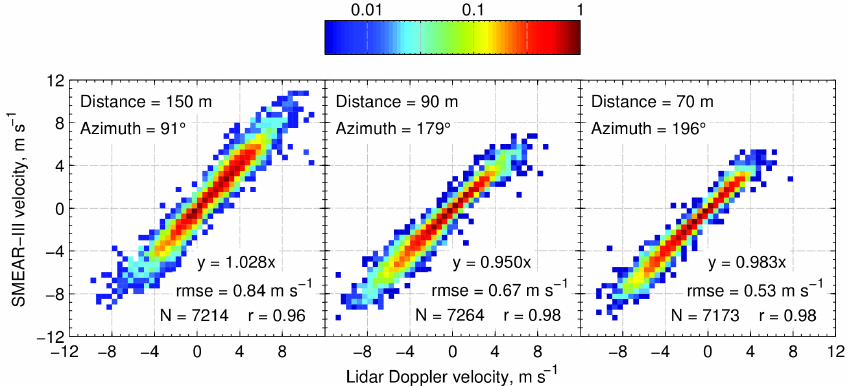
Fig. 9. Comparison of single-beam and range gate Doppler velocity with co-located sonic anemometer velocity: measurements with different horizontal separation from sonic anemometer are shown, and subsequent statistical parameters are also presented: number of half-an-hour mean velocity samples ( N ), root mean square error (RMSE), Pearson correlation ( r ) and slope of fitted linear